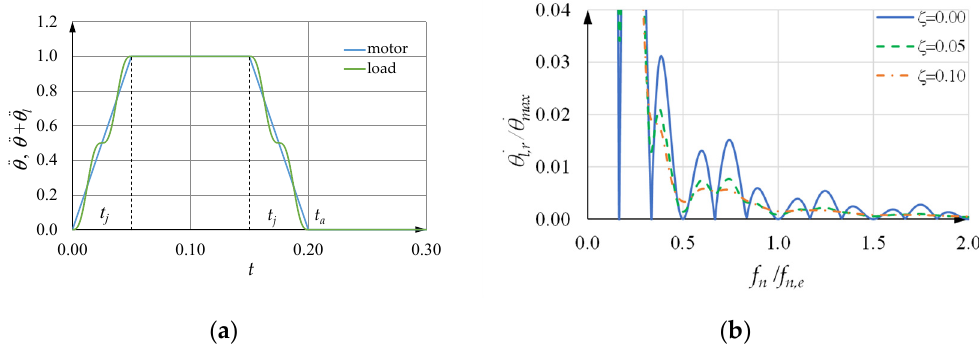
= 2/ f n , e and f n = f n , e ; ( b ) sensitivity curve when Figure 15. ( a ) Motor and load acceleration when and Figure 15. ( a ) Motor and load acceleration when t j Figure 15. ( a ) Motor and load acceleration when and .